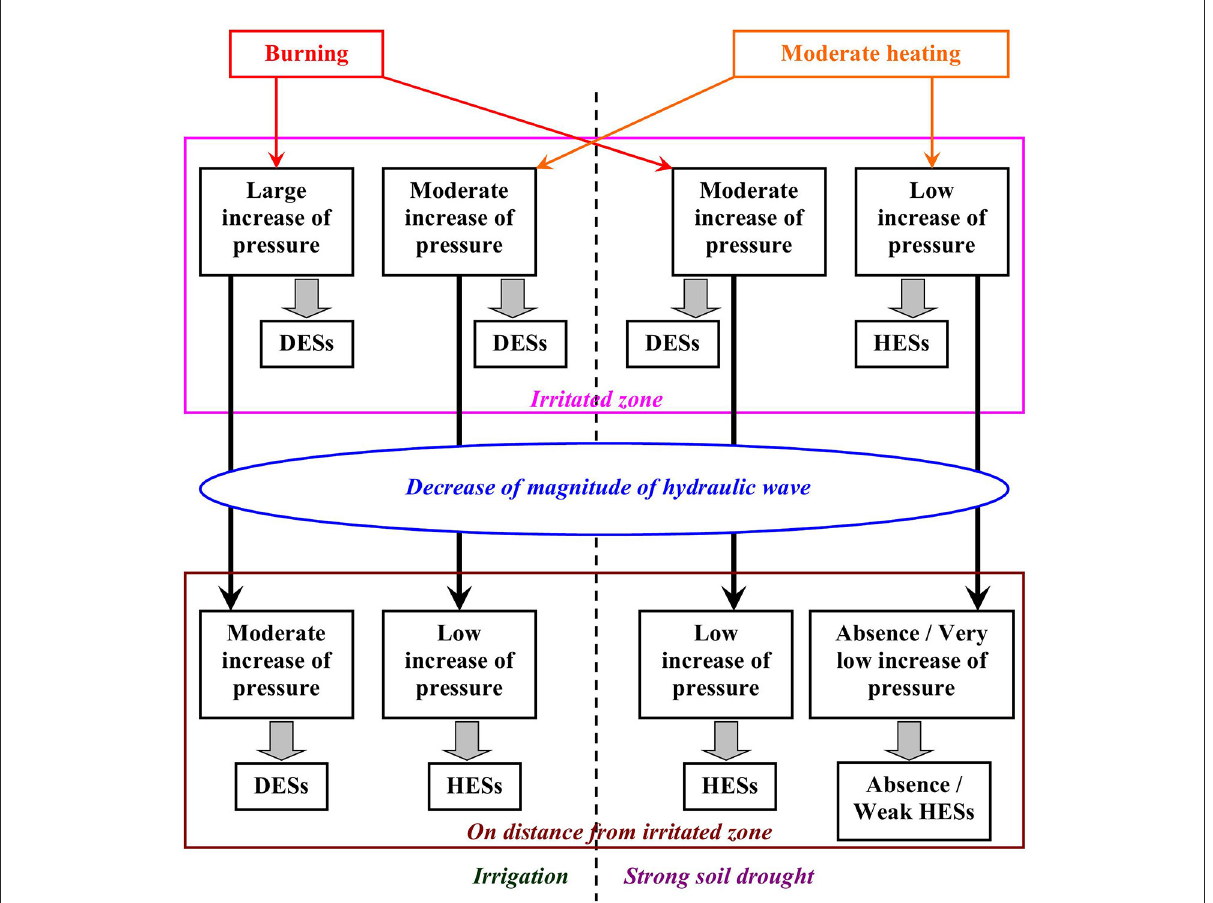
FIGURE8 Hypothetical scheme of propagation of depolarization electrical signals (DESs) and hyperpolarization electrical signals (HESs) induced by local burning and moderate heating in the plants under irrigated conditions and drought conditions. The scheme is based on the current results and results of the previous work (Yudina et al., 2022). The ESs induced by local illumination are not shown in this scheme; it is probable that ways of induction of HESs by local illumination are similar to ones under the local moderate heating, but magnitude of the hydrostatic pressure increase is